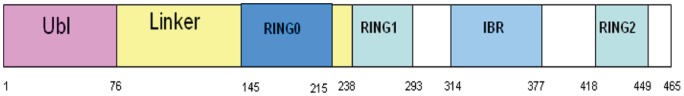
Schematic representation of Parkin domains.